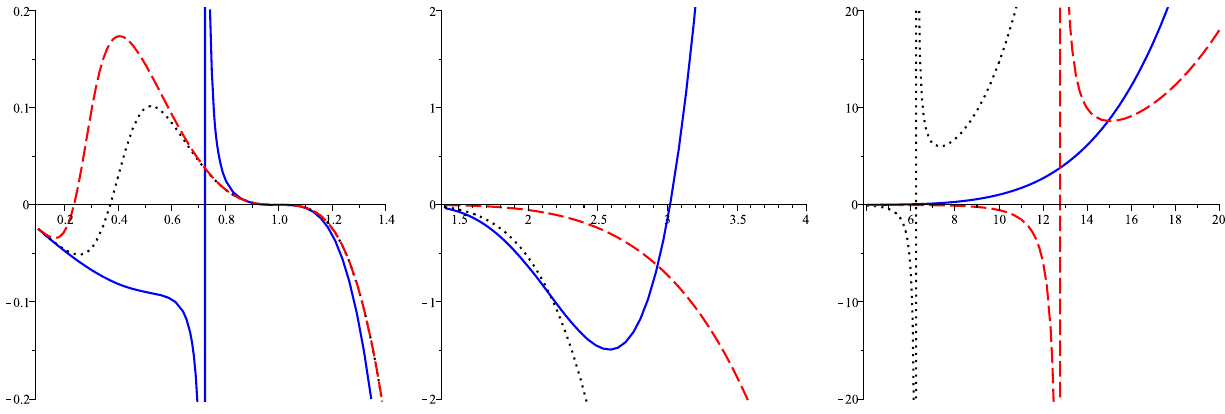
Fig. 14 C P , X versus r + for k = − 1, d = 7, q = 1, α = 1, P = 1 / 8 π , m = 0 . 1, c 1 = c 2 = c 3 = c 4 = 1 and c 0 = 1 (solid line), c 0 = 5 (dotted i line) and c 0 = 10 (dashed line). Different scales: left panel (0 < r + < 1 . 4), middle panel (1 . 4 < r + < 4) and right panel (4 < r + <